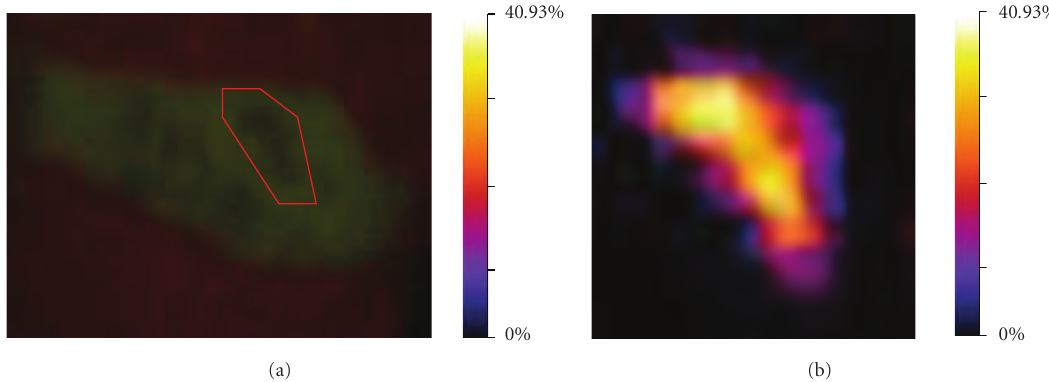
Figure 3: QLF images were analyzed by a novel image processing software. The region of interest [ROI] is shown as the red polygon (a). The resulting image of ROI [magnified × 5] after processing is colored according to the Fire Look-Up Table [LUT] (b).